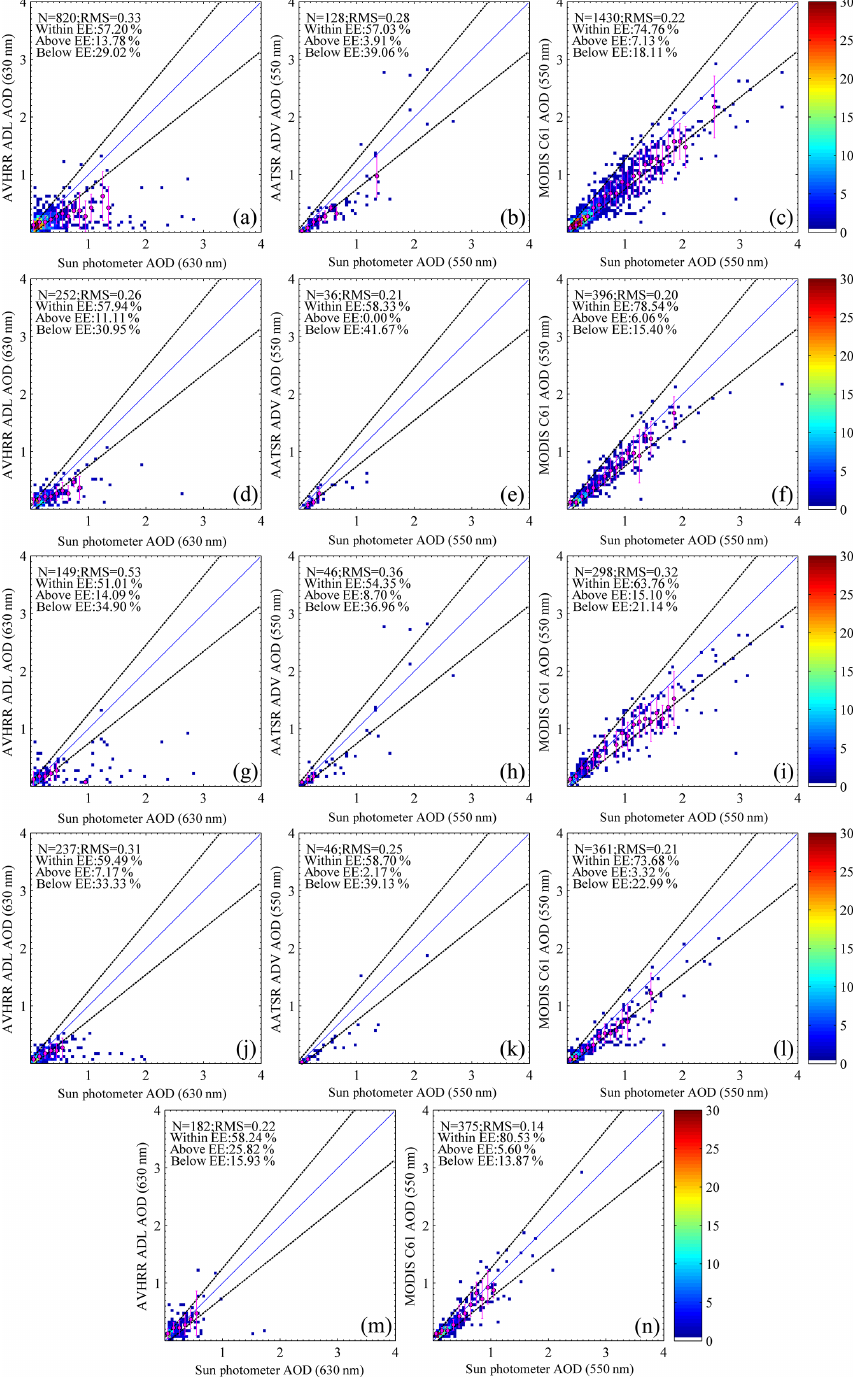
Figure A3. Scatter density plots of satellite-retrieved AOD vs. sun-photometer-retrieved AOD data from XiangHe station. The ADL of all data (a) , only spring data (d) , only summer data (g) , only autumn data (j) and only winter data (m) vs. AERONET. The ADV of all data (b) , only spring data (e) , only summer data (h) and only autumn data (k) vs. AERONET. MODIS using all data (c) , only spring data (f) , only summer data (i) , only autumn data (l) and only winter data (n) vs.